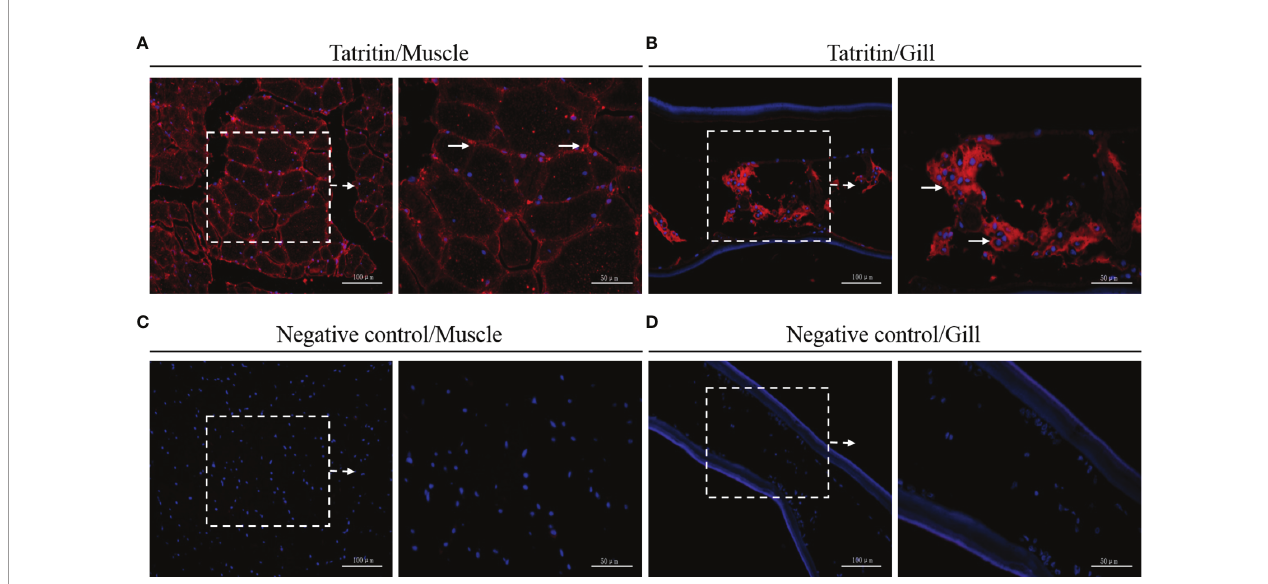
FIGURE 3 | Immuno fl uorescence detection of Tatritin in muscle and gill. Cryosections were stained with speci fi c antibody for Tatritin (red) and with DAPI for nuclei (blue). Signals of Tatritin peptide were observed in muscle (A) and gill (B) . Controls were stained with anti-GST antibody in muscle (C) and gill (D) . The right image of each panel shows the enlarged image of the area outlined in the left image. The long arrows indicate location expressing Tatritin in endomysium and sarcoplasm of muscle or in the cavity of